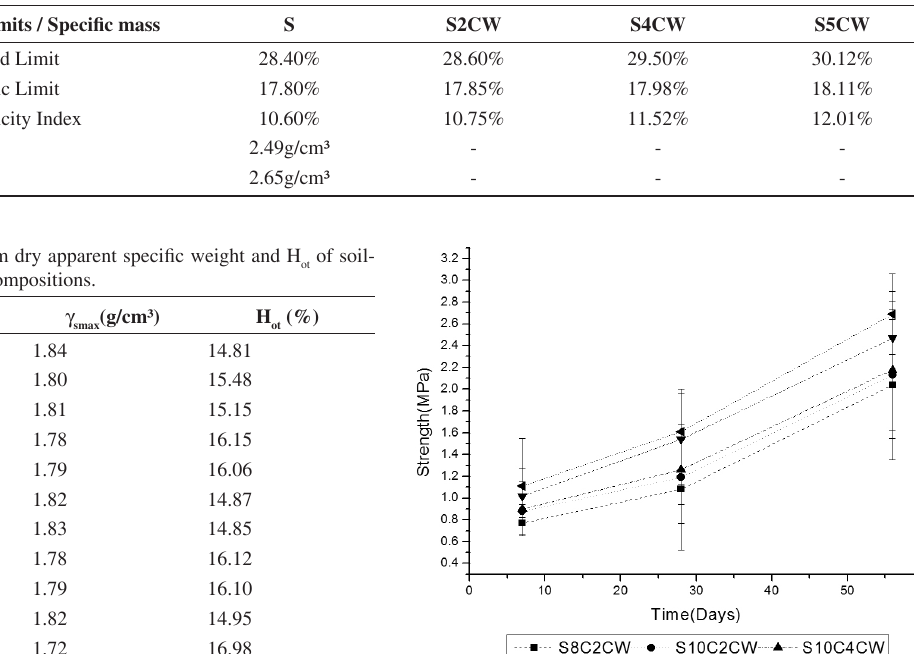
Table 2. Atterberg Limits / Specific mass of soil and CW.